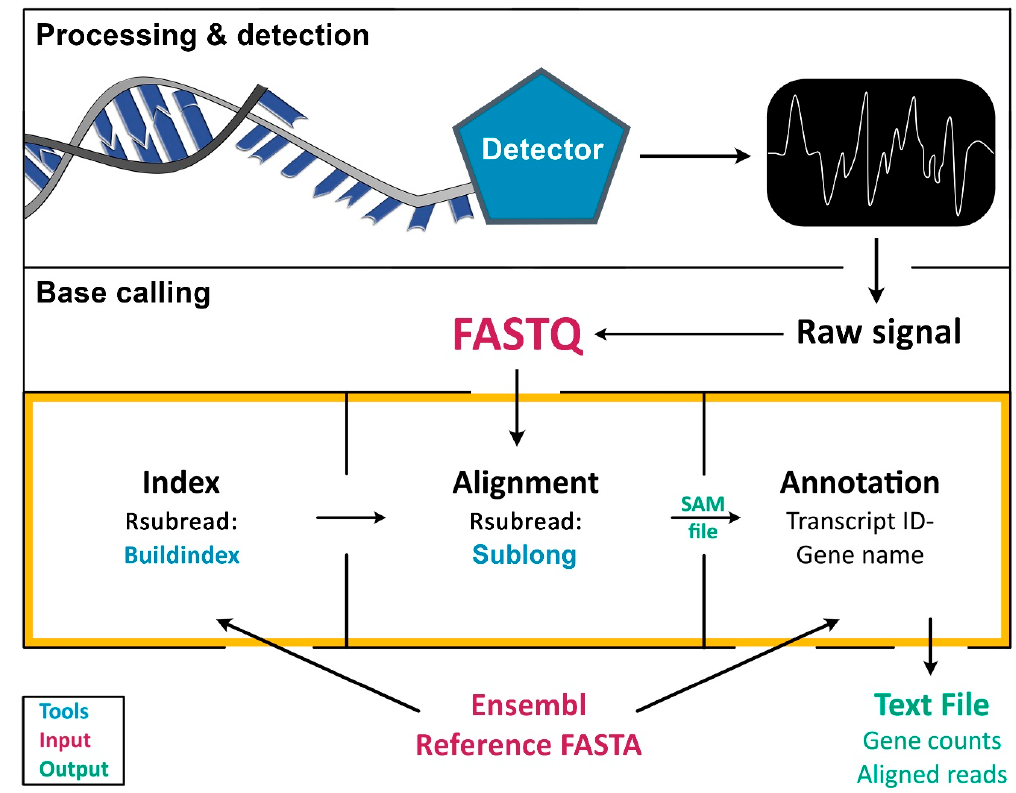
Figure 1. Principle of sequencing data processing and implementation of Alignator v1. The process of RNA sequence analysis is divided into three major steps: following RNA isolation, raw signals are obtained during RNA sequencing (Processing & detection). Raw signals are then converted into sequence data (Base calling), which can be aligned and quantified. The orange frame marks the tasks implemented in Alignator v1, including index generation, alignment, and annotation of the aligned reads. Tools that are used by Alignator v1 are marked in blue, whereas required input files are depicted in red. Successful runs will produce the three output files shown in